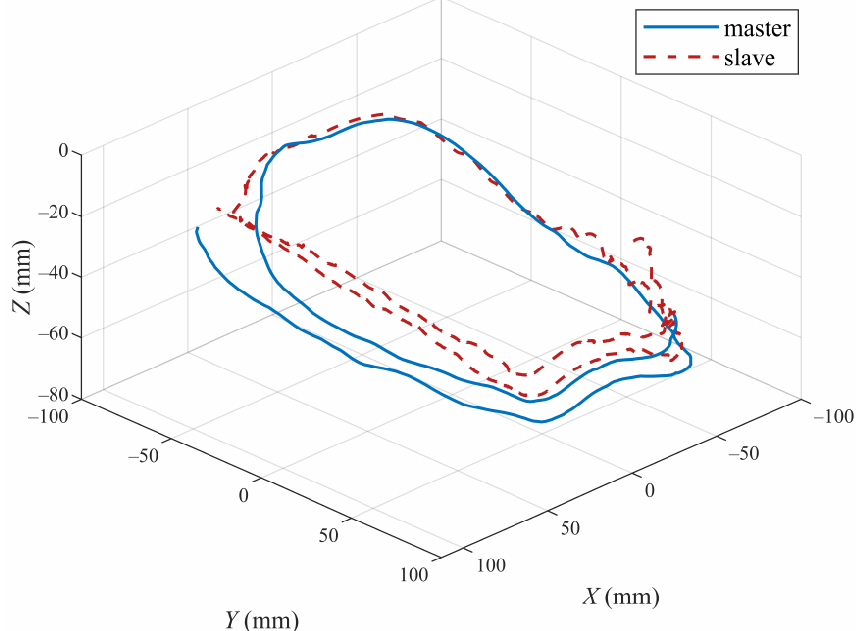
Figure 14. Tracking control performance of end-effectors of master and slave robots under experiment case 1.